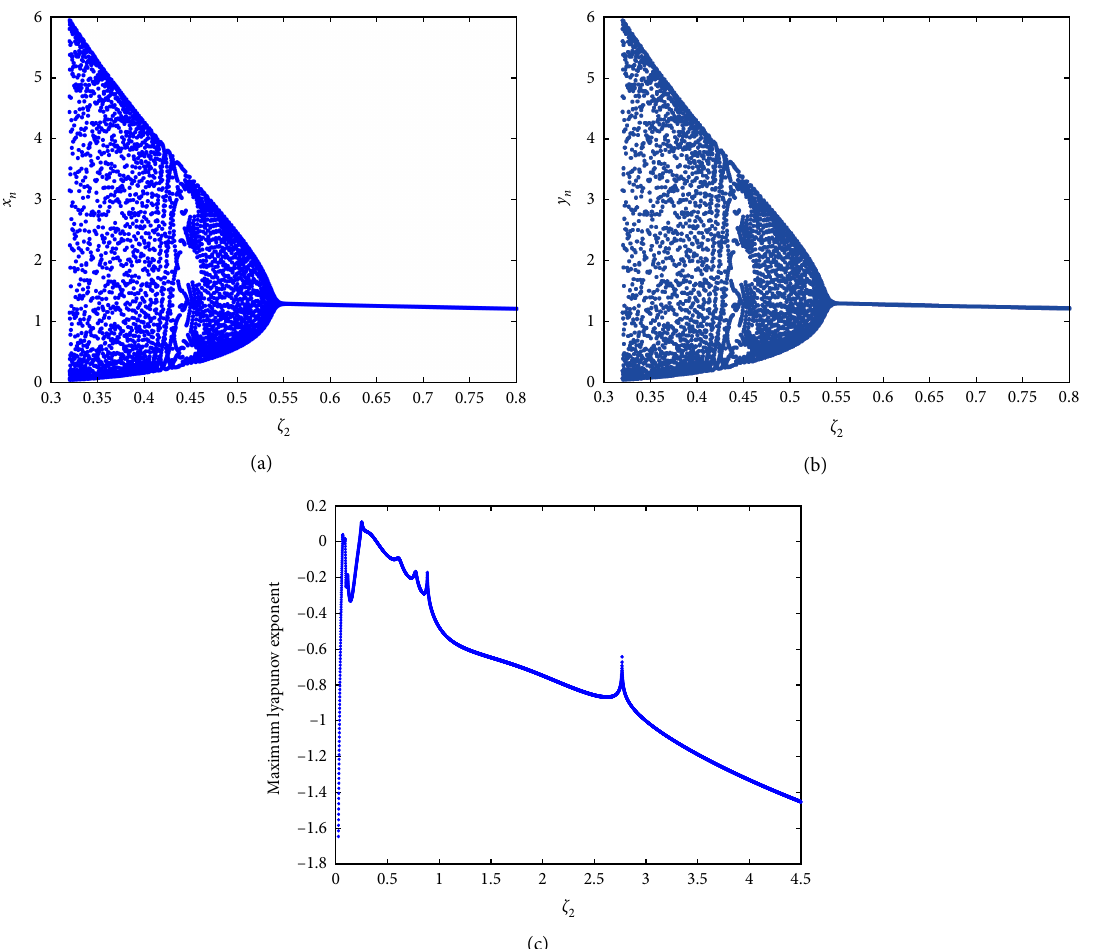
𝑟 𝑟 . (a)-(b) 𝐵 (( 𝑟𝑒 ) / ( 𝑒 − 1 ) , 𝑟 )